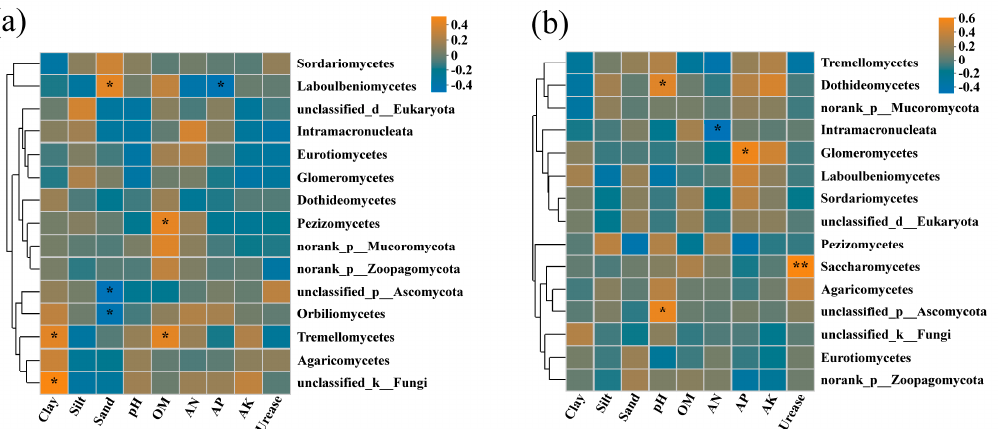
Figure 7. Correlation heatmaps between the fungal community at the class level and the physico- chemical properties of cassava rhizosphere soil collected in 2019 ( a ) and 2020 ( b ), respectively. OM, organic matter; AN, available nitrogen; AP, available phosphorus; AK, available potassium. * p < 0.05, ** p < 0.01.